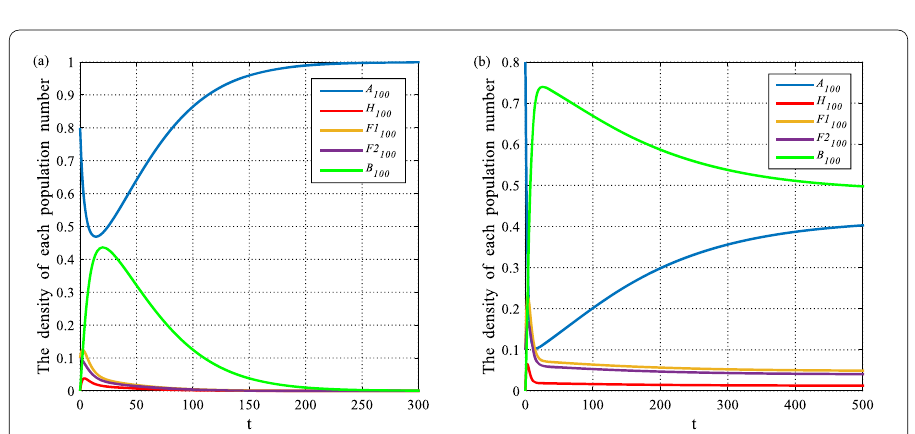
Figure 10 Population changes for each compartment over time in competition model when R 0 < 1 ( a ) and R 0 > 1 ( b